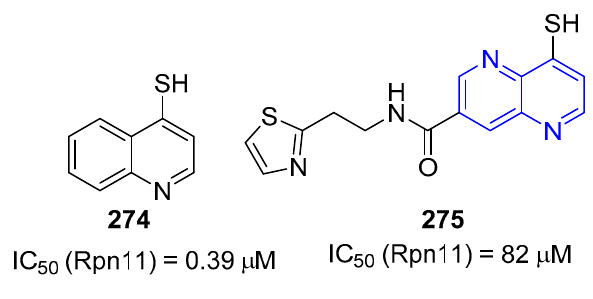
Figure 6. Inhibition of Rpn11.